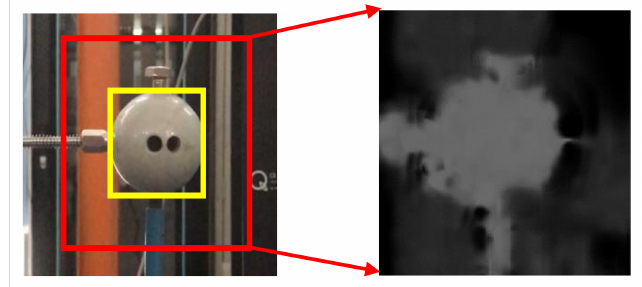
Figure 7. Local context and influence